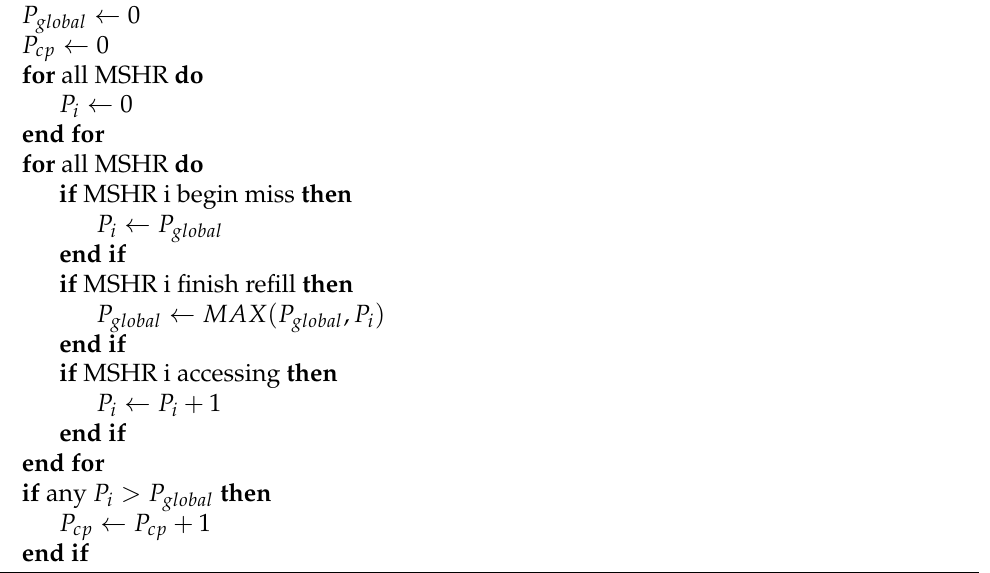
Algorithm 3 Memory time estimation method based on critical path.